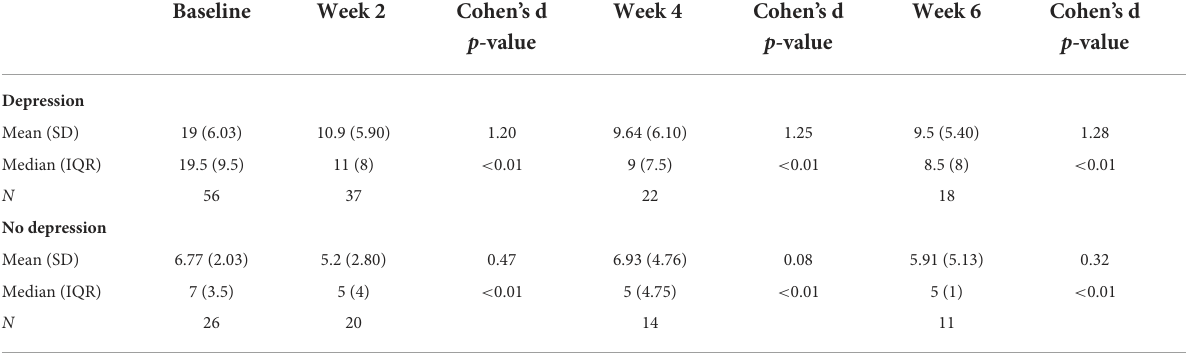
TABLE 8 The table shows the depression scores of two groups based on the clinically significant score cutoff of 10 for all time points. Baseline Week 2 Cohen’s d Week 4 Cohen’s d Week 6 Cohen’s